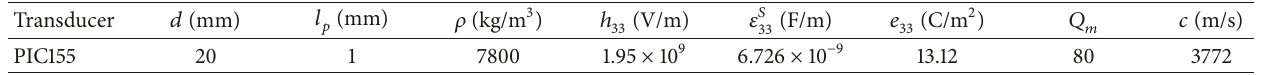
Table 1: Material properties and geometric parameters of PIC155 piezoelectric transducer.